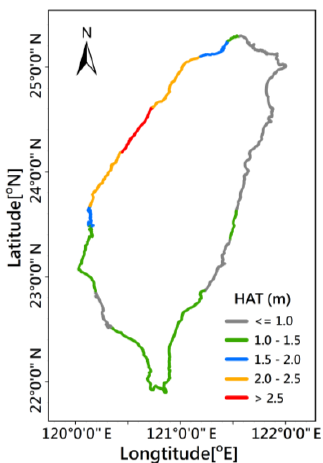
Figure 5. The distribution of the highest astronomical tides (HATs) along the coast of Taiwan.